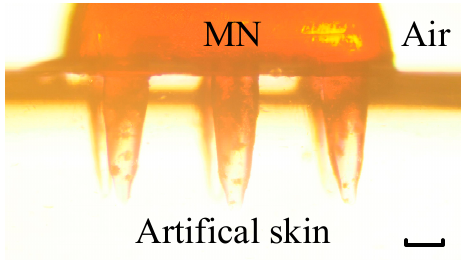
Figure 3. The state MNs was stuck into artificial skin (5 wt% alginate hydrogel). The scale bar is 200 µm.